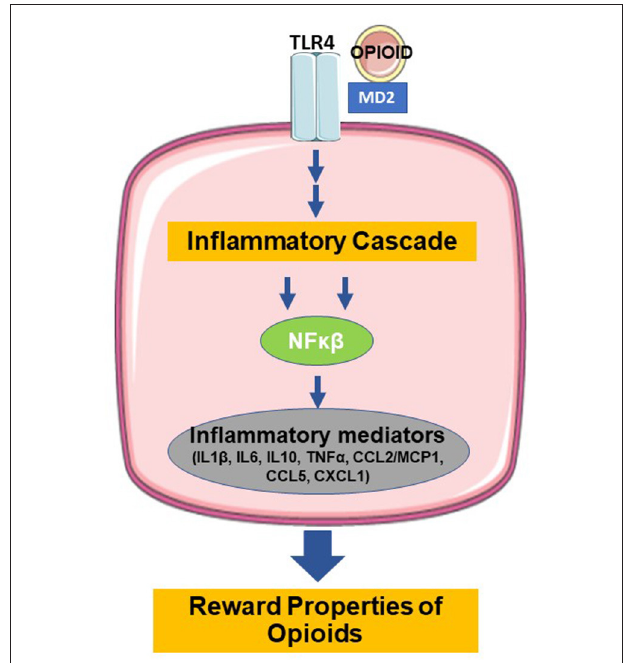
FIGURE 1 | Binding of opioids with TLR4 induces the release of inflammatory mediators and modulation of the reward properties (TLR4 = toll-like receptor type 4, MD = myeloid differentiation, NF κ B = nuclear factor kappa beta, IL1 β = interleukin 1 beta, IL6 = interleukin 6, IL10 = interleukin 10, TNF α = tumor necrosis factor alpha, CCL2 = C-C motif chemokine ligand 2, MCP1 = monocyte chemoattractant protein 1, CCL5 = C-C motif chemokine ligand 5, CXCL1 = C-X-C motif chemokine ligand 1. Figure created using derivatives of “Cellular Biology,” Servier Medical Art